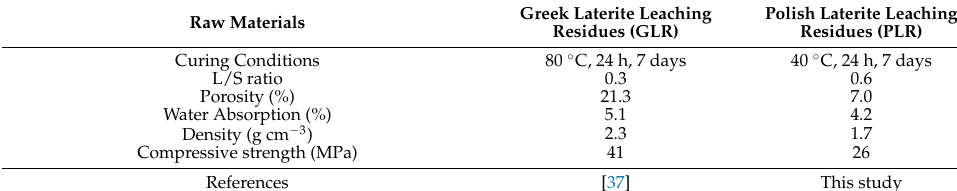
Table 8. Cont. Raw Materials Greek Laterite Leaching Residues